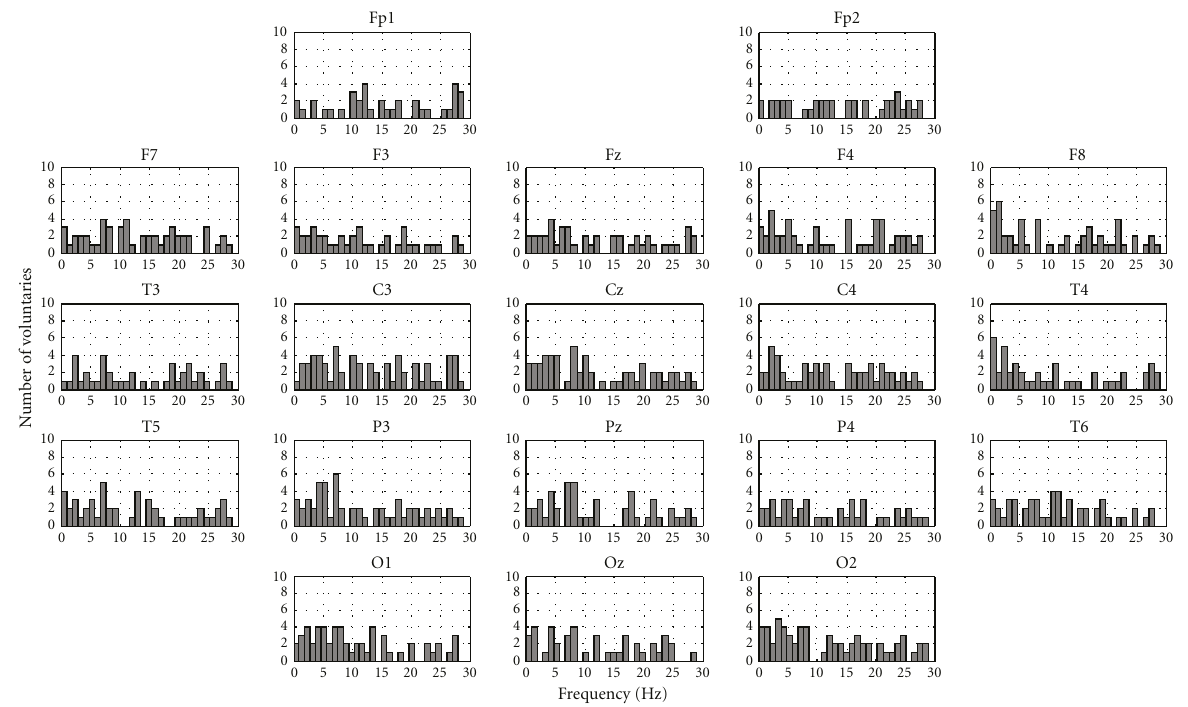
Figure 9: Histogram (bin width 1 Hz) topographic distribution displaying the number of subjects with response after MSC application higher than the critical value (significance level 5%) for spontaneous EEG’s ERPs, with lighted LEDs, harmonics from 0 to 30 Hz. Frequencies higher than 30 Hz did not show significant